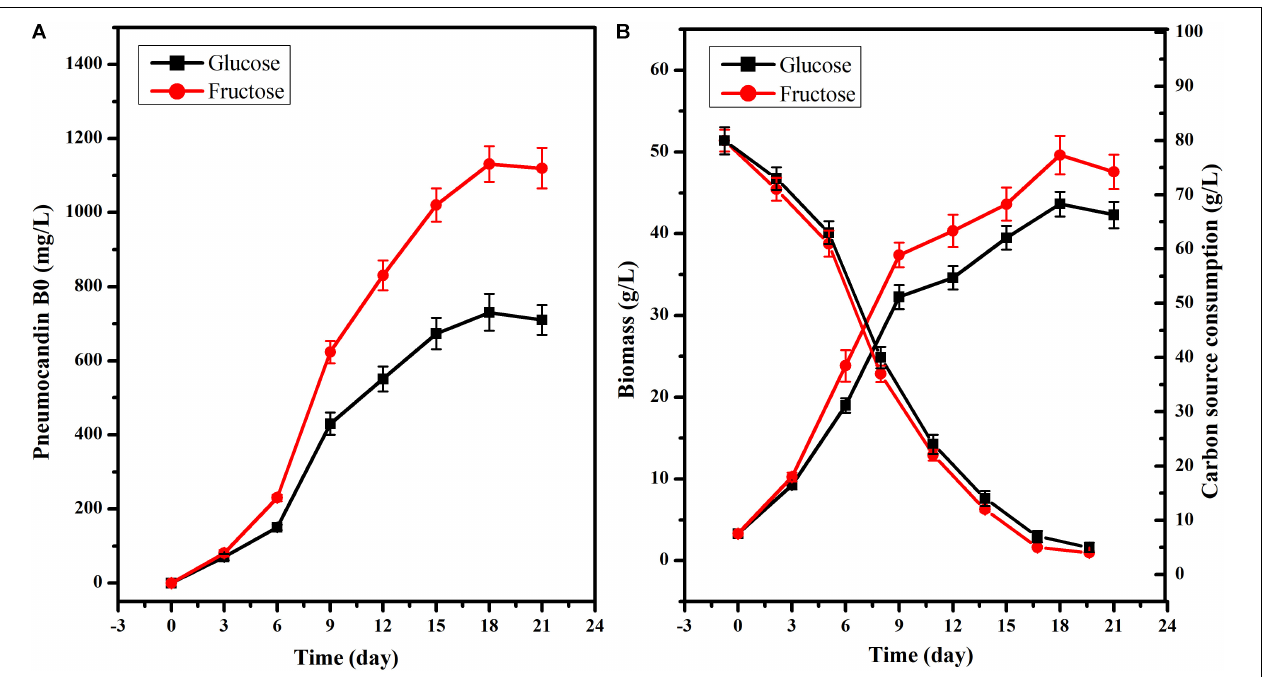
FIGURE 2 | Effects of glucose and fructose on cell growth and PB 0 production. (A) Pneumocandin B 0 (mg/L), (B) Biomass (g/L), Fructose, and glucose consumption. The data were presented as the averages of three parallel samples, and the error bars indicate the standard deviation (SD) from the means of triplicates.